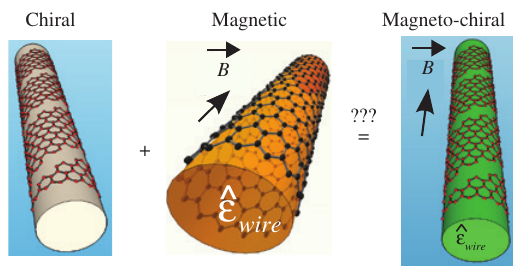
Figure 9: The concept of hybrid magneto-chiral nanostructures for possible non-reciprocal magnetic compensation of the chirality